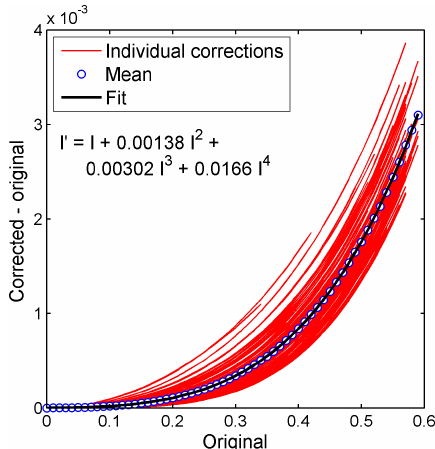
Figure A1. Plot showing the difference of the corrected interfero- grams – original interferograms vs. the original interferograms. The individual corrections are plotted in red, the mean value is plotted as blue open circles, and the black line is the